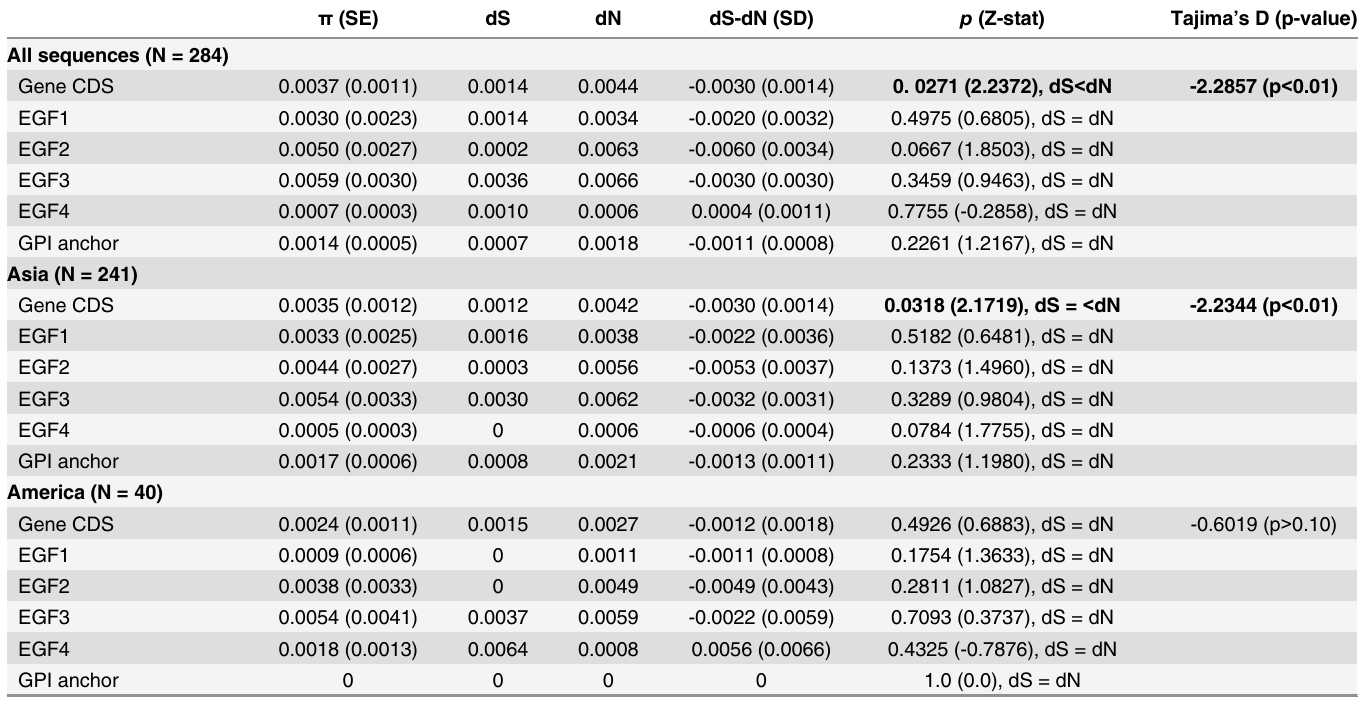
Table 1. Pvs28 worldwide polymorphism by gene CDS and gene-domain.